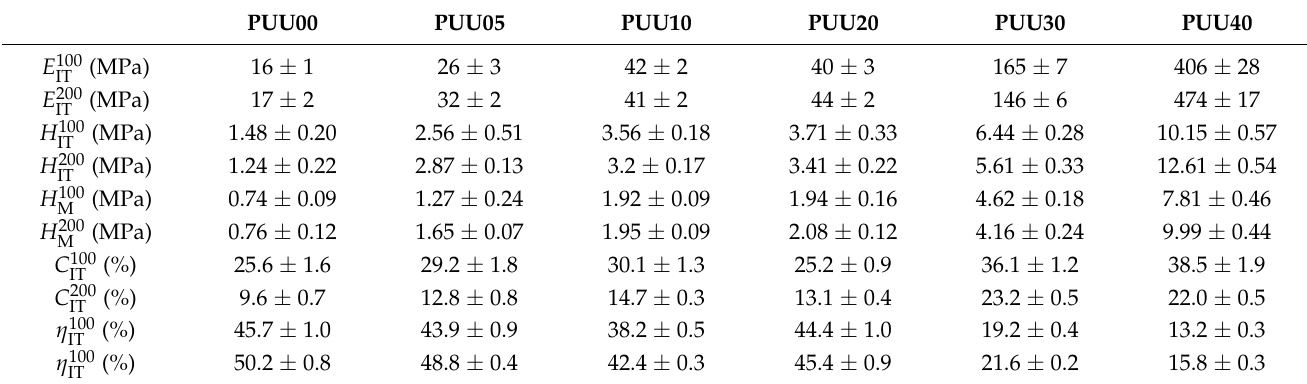
Table 3. Microindentation hardness testing results—micromechanical properties at 25 ◦